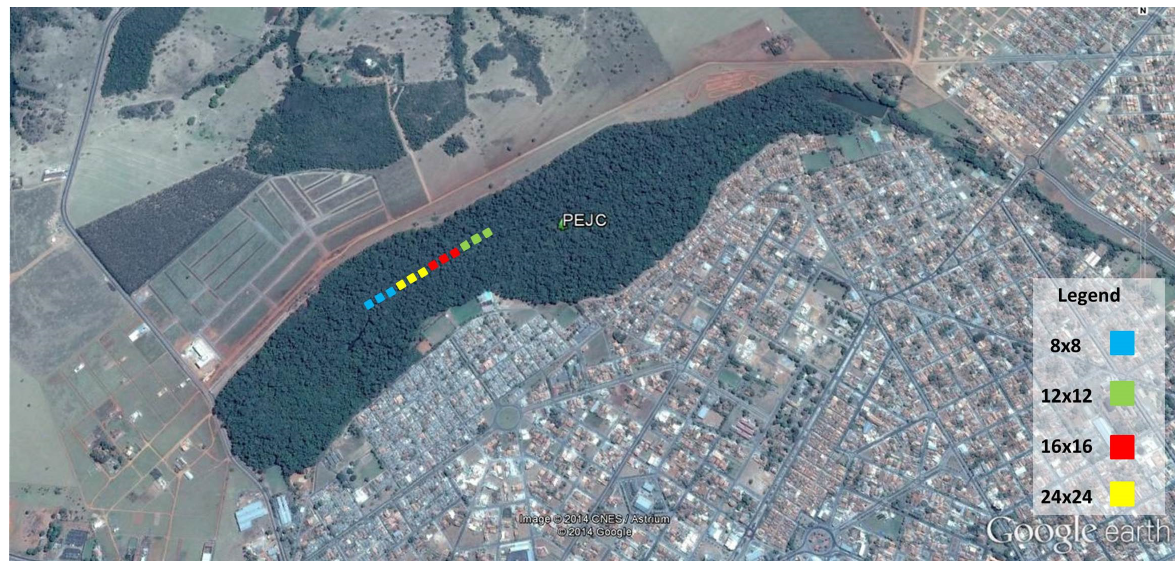
Figure 1. Satellite image - Ecological Park Centennial Jatoba (PEJC) Morrinhos-GO, Brazil showing quadrant pattern. Source: Google Earth